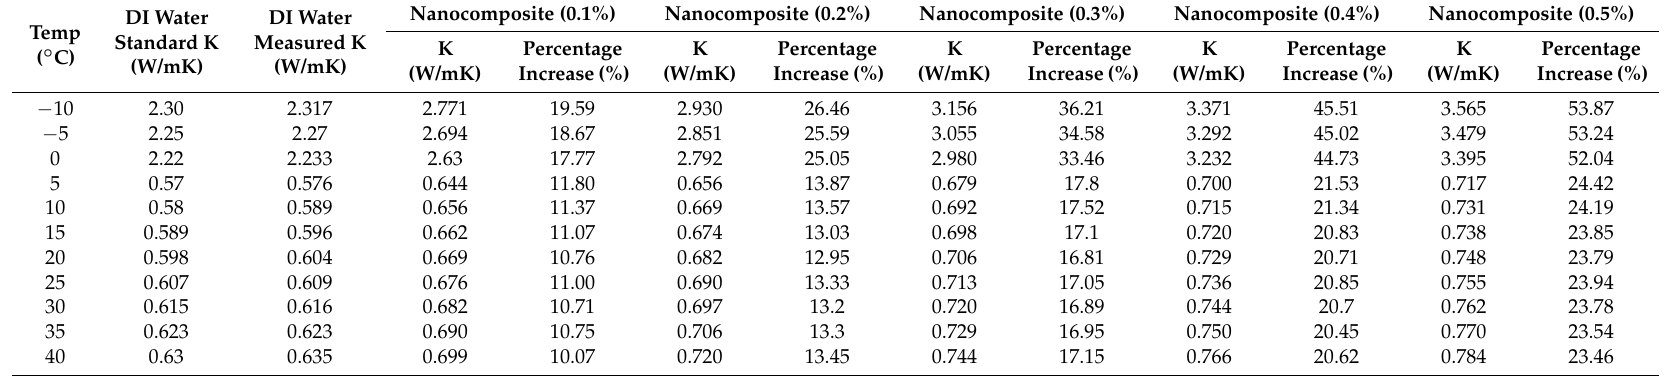
Table 2. Thermal conductivity of nanocomposite with respect to temperature and